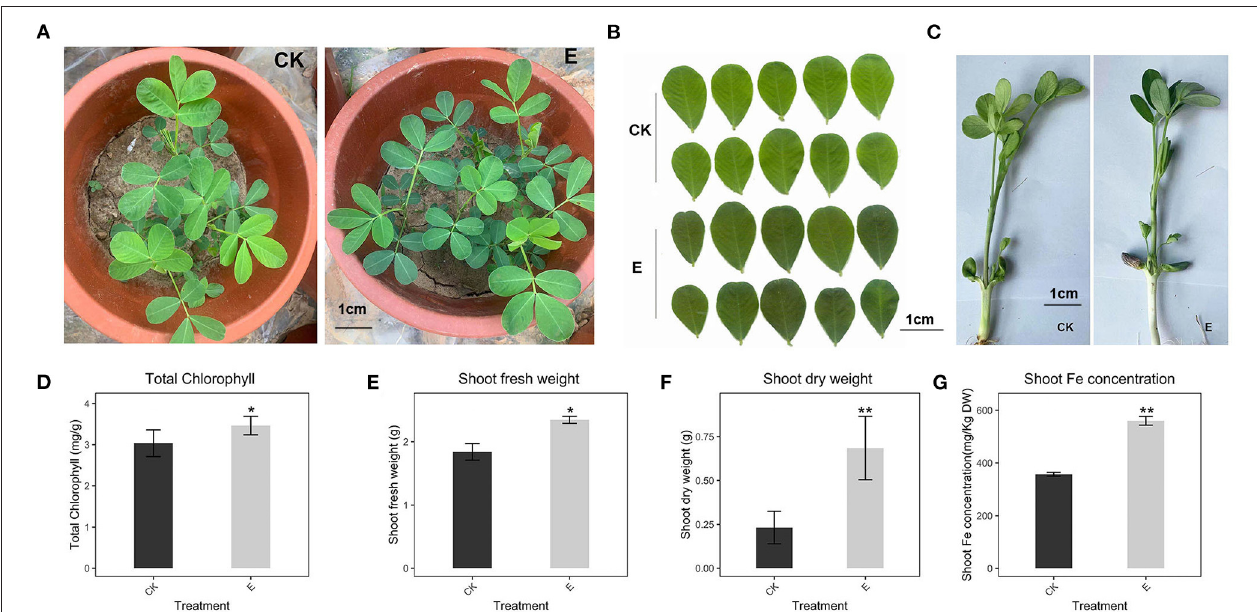
FIGURE 1 | Effect of P. liquidambaris on peanut growth in alkaline soil. (A) : Effect of P. liquidambaris on peanut appearance in pot experimental. (B) : Effect of P. liquidambaris on peanut leaf color. (C) : Effects of P. liquidambaris on peanut shoot in seedling stage. (D) : Effect of P. liquidambaris on chlorophyll content of peanut. (E) : Effect of P. liquidambaris on shoot fresh weight of peanut. (F) : Effect of P. liquidambaris on shoot dry weight of peanut. (G) : Effect of P. liquidambaris on shoot Fe concentration of peanut. Data and errors are mean ± SD ( n = 6). Black asterisks indicate the significant differences between groups (* p < 0.05; ** p < 0.01; t